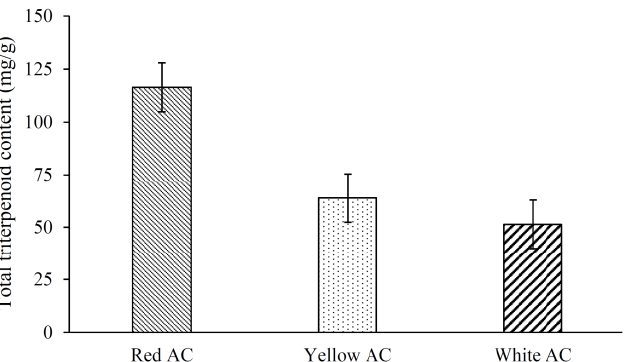
Figure 2. Total triterpenoid contents in fruiting bodies of different A. cinnamomea phenotypes. Values are mean ± SD ( n = 4).